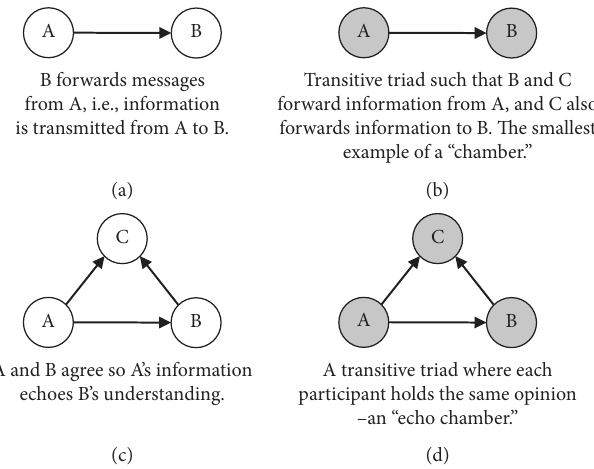
Figure 3: Structural and attitudinal components of an echo chamber in participation